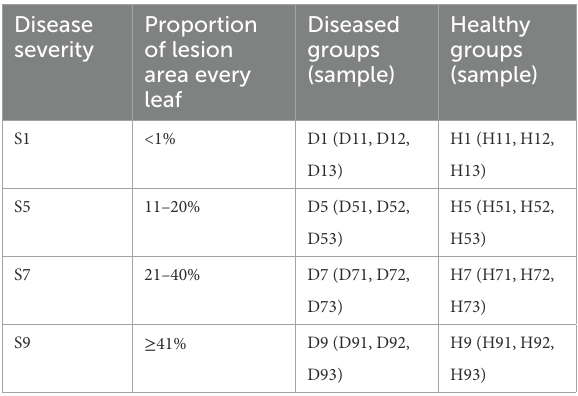
TABLE 1 Sample information for both diseased and healthy tobacco leaves infected tobacco target spot at different disease severity. Disease